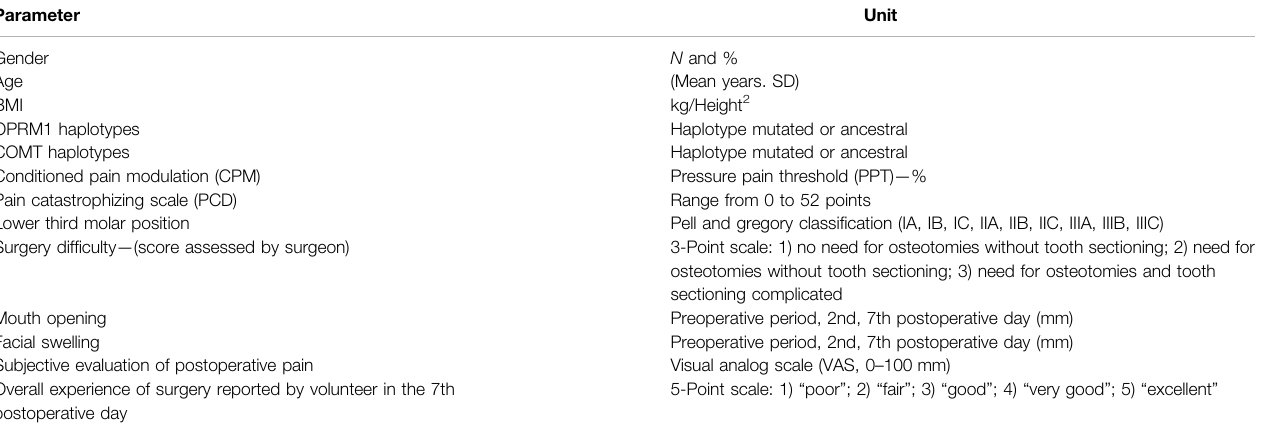
TABLE 1 | Preoperative, intraoperative and postoperative parameters.